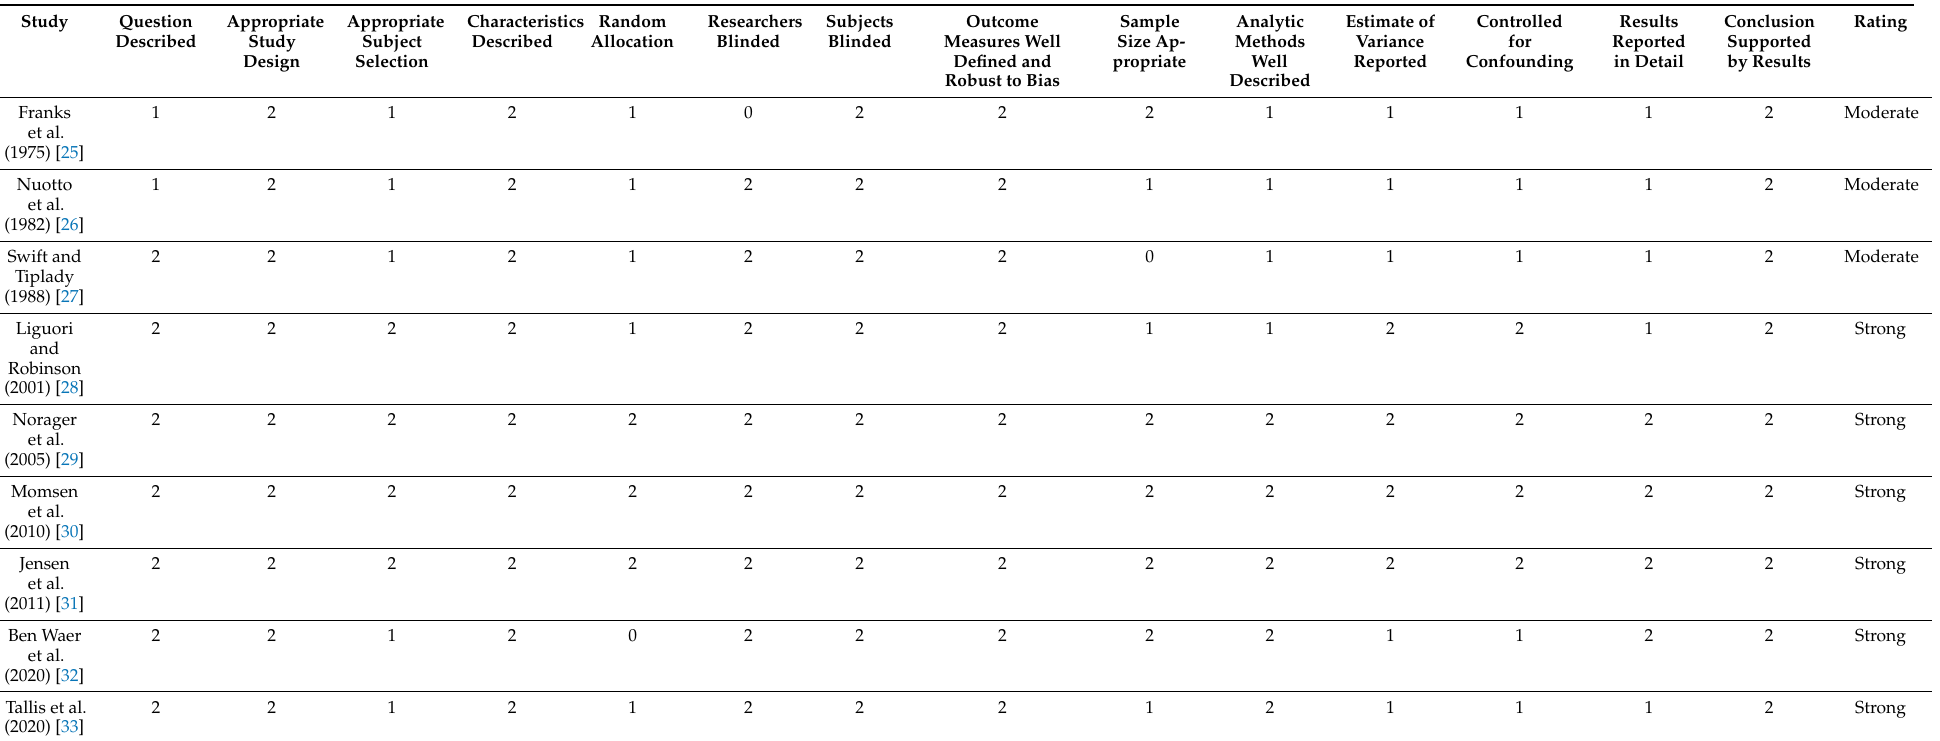
Table 3. QualSyst assessment of study quality and risk of bias